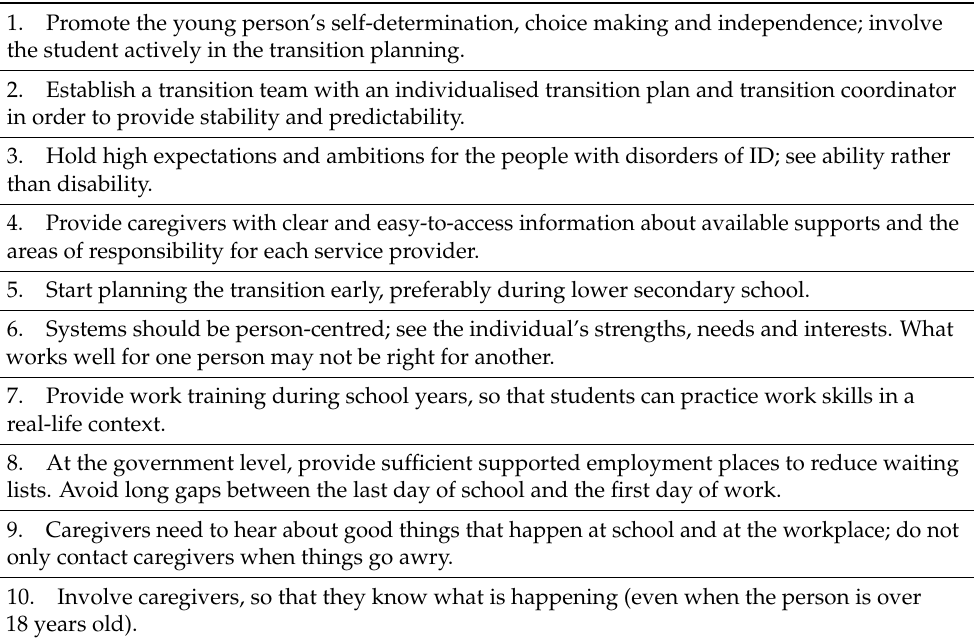
Table 2. Ten suggestions for measures to support effective school–work